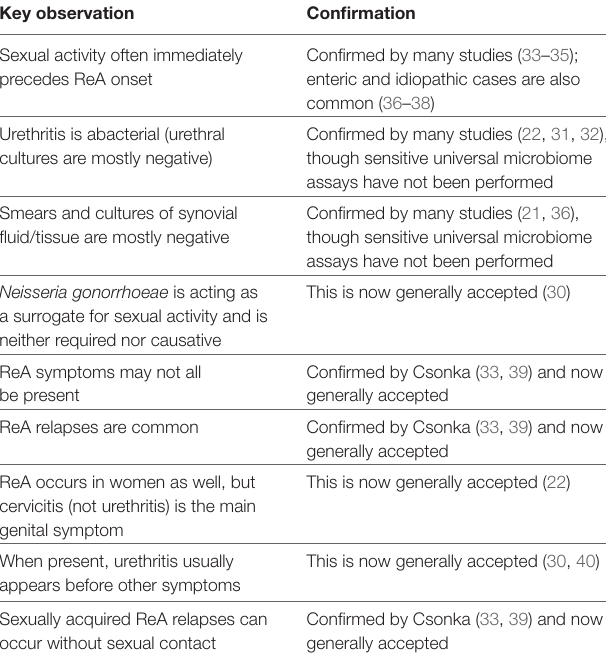
table 1 | Nine key observations in Harkness’ 1949 review of